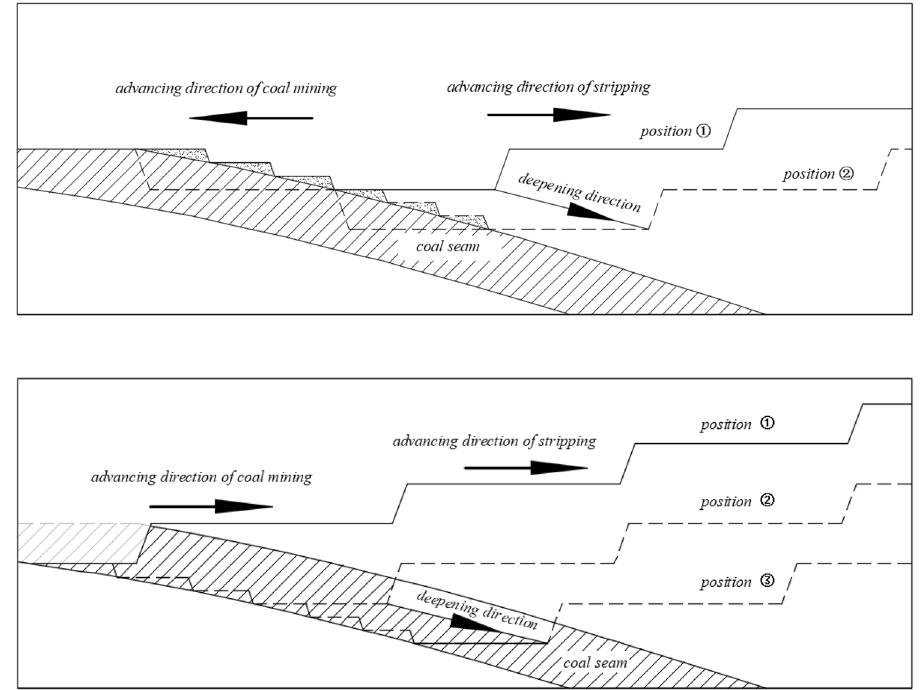
Fig. 4 Coal exposure method of deepening along coal seam roof and advancing to both sides